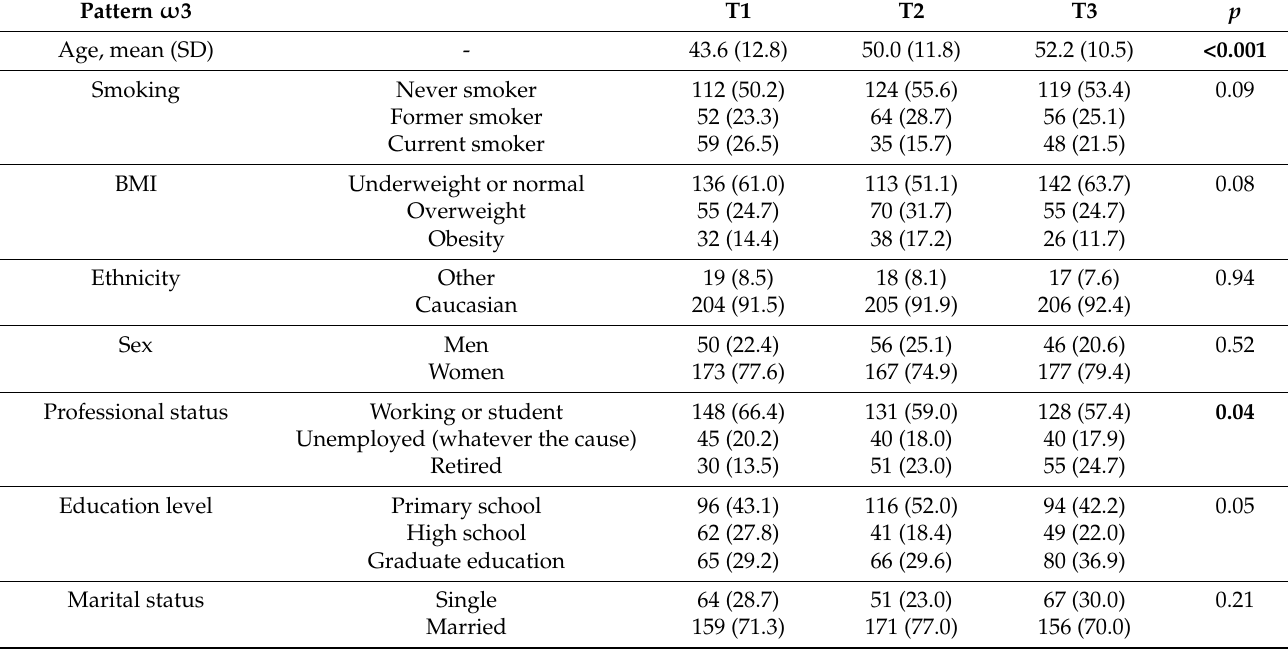
Table 3. Univariate analysis of the association between pattern ω 3 and patient characteristics at inclusion in the